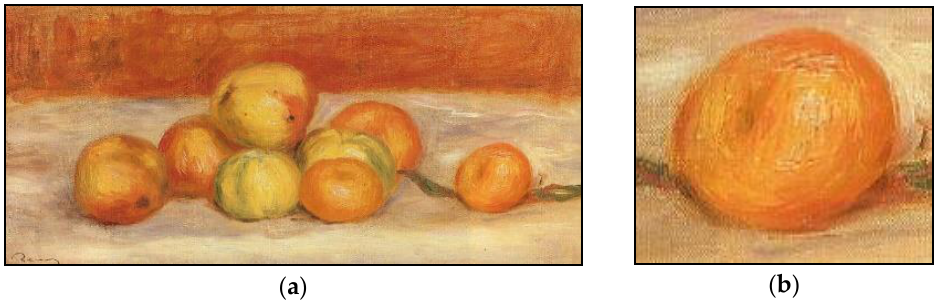
Figure 8. ( a ) “Apples and Manderines” Renoir (impressionism), ( b ) enlargement of selected re- gion.